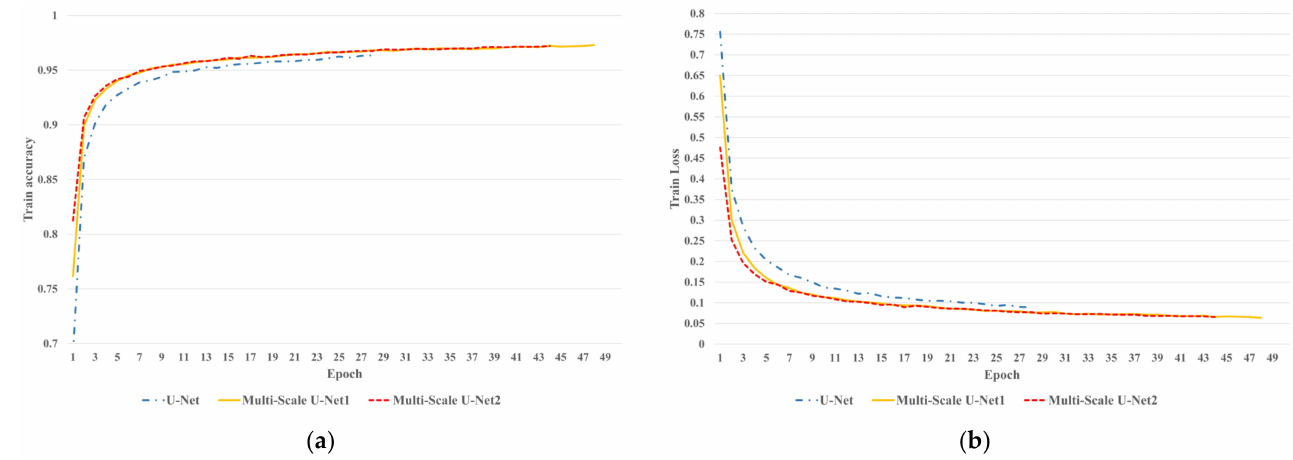
Figure 15. Train accuracy and train loss. ( a ) Train accuracy, ( b ) Train